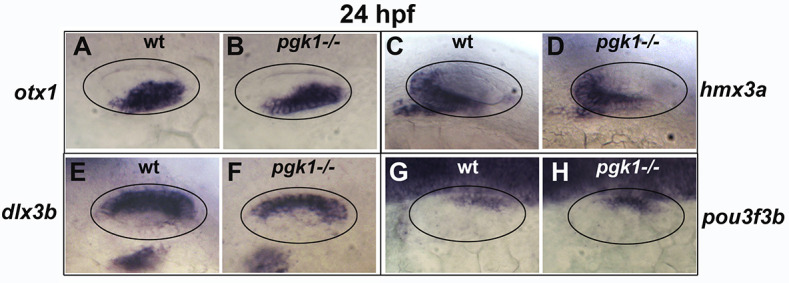
pgk1– / - mutants show normal expression of regional markers of the otic vesicle.(A–H) Otic expression of the indicated genes at 24 hpf in wild-type embryos and pgk1- / - mutants. Images show dorsolateral views with anterior to the left.